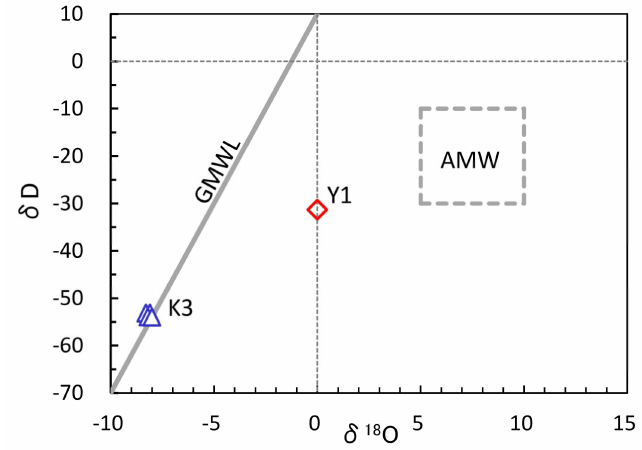
Figure 9. Oxygen and hydrogen isotope ratios of the spring K3 and the hydrothermal pond Y1 water. The “Andesitic magmatic water” (AMW) [57,58] and “global meteoric water line” (GMWL) [59] are also